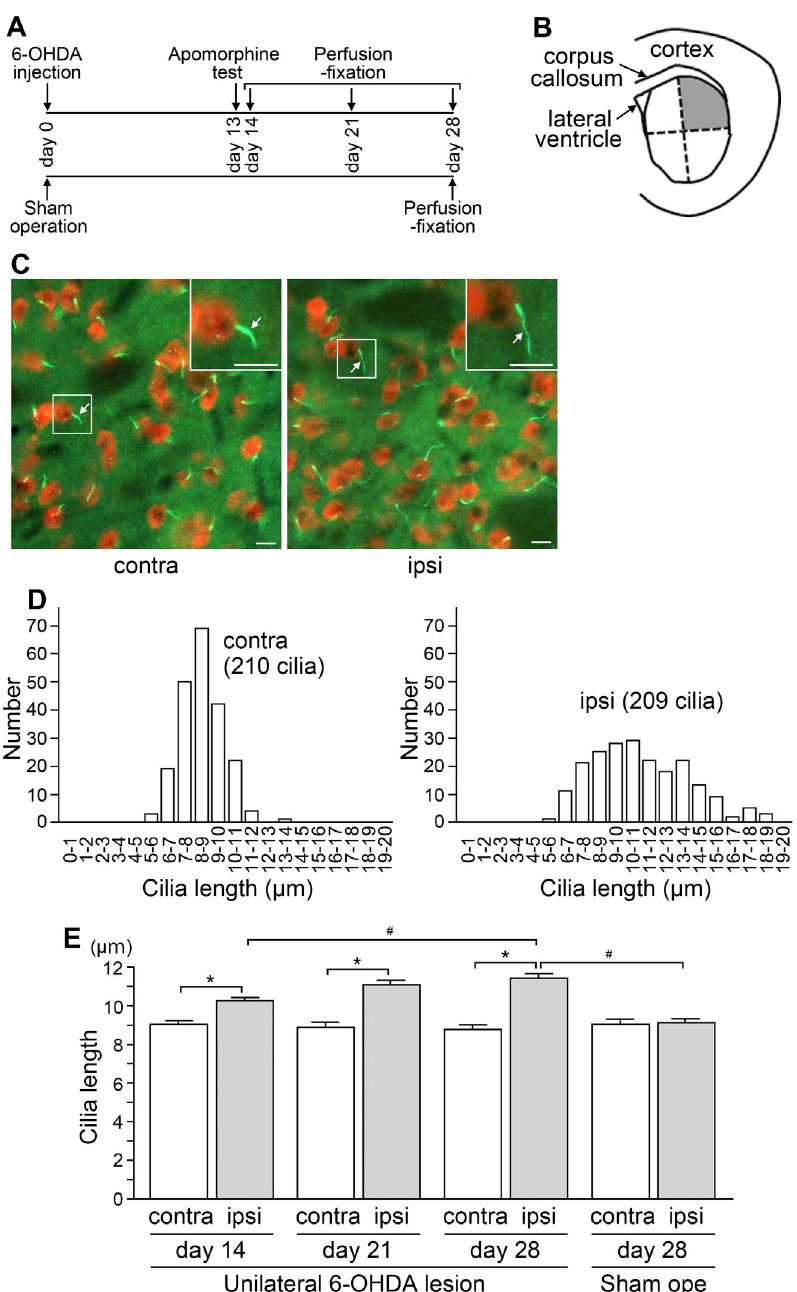
Figure 1. Nigrostriatal dopaminergic lesions lead to the elongation of primary cilia of striatal neurons in rats. (A) Generation and perfusion-fixation of hemi-parkinsonian rats. Rats that received unilateral 6-OHDA injection into the nigrostriatal dopamine pathway on day 0 and displayed asymmetric rotation in the apomorphine test on day 13 were fixed on day 14, 21 or 28. Sham-operated rats were fixed on day 28. Each group included four rats. (B) A drawing indicating the dorsolateral quarter of the striatum (shaded gray), where neuronal cilia were analyzed. (C) An immunofluorescence analysis of the dorsolateral striatum from the unilaterally nigrostriatal-lesioned rat that was fixed on day 28. Primary cilia stained with an antibody to AC3 (green) protruded individually from NeuN-positive neuronal cell bodies (red) on the contralateral (contra) and ipsilateral (ipsi) sides. Insets show higher-magnification views of the boxed areas. Arrows=primary cilia; scale bars=10 m m. (D) Lengths of AC3-positive cilia protruding from NeuN-labeled neurons were analyzed in the dorsolateral striatum. At least 200 cilia on each side from the respective animals were measured. Histograms show the distributions of cilia lengths on both sides of the striatum from a representative unilaterally-lesioned rat on day 28. (E) The average cilia length in the dorsolateral striatum of both sides from each of four rats in the respective groups was calculated. The data are expressed as means 6 SEM of four average values from unilaterally 6-OHDA-lesioned rats fixed on day 14, 21 or 28, and sham-operated (Sham ope) rats fixed on day 28. In the lesioned rats, striatal neuronal cilia were significantly longer on the ipsilateral side than on the contralateral side (* P , 0.01). Significant differences were observed between the ipsilateral sides on day 28 of the 6-OHDA-lesioned rats and of the sham-operated (Sham ope) rats, and between the ipsilateral sides on day 14 and on day 28 of the 6-OHDA-lesioned rats ( # P , 0.05).